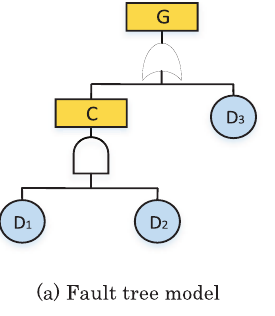
Fig. 2. Transformation of fault tree